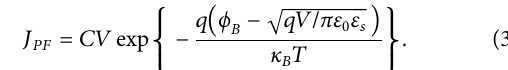
Frontiers in Materials |